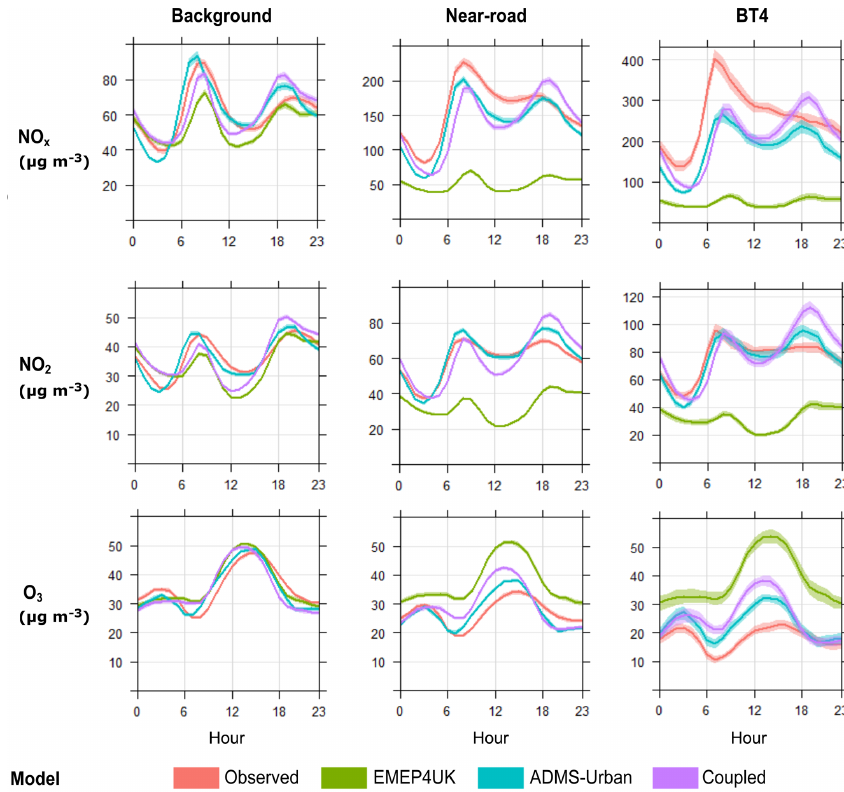
Figure 13. Diurnal temporal variations of NO x , NO 2 and O 3 concentrations for the average over all background and near-road sites, and for an individual near-road site, with observations and modelled concentrations from each model. Note different concentration axis limits for each plot. The shaded area around the central line shows the 95% confidence interval in the